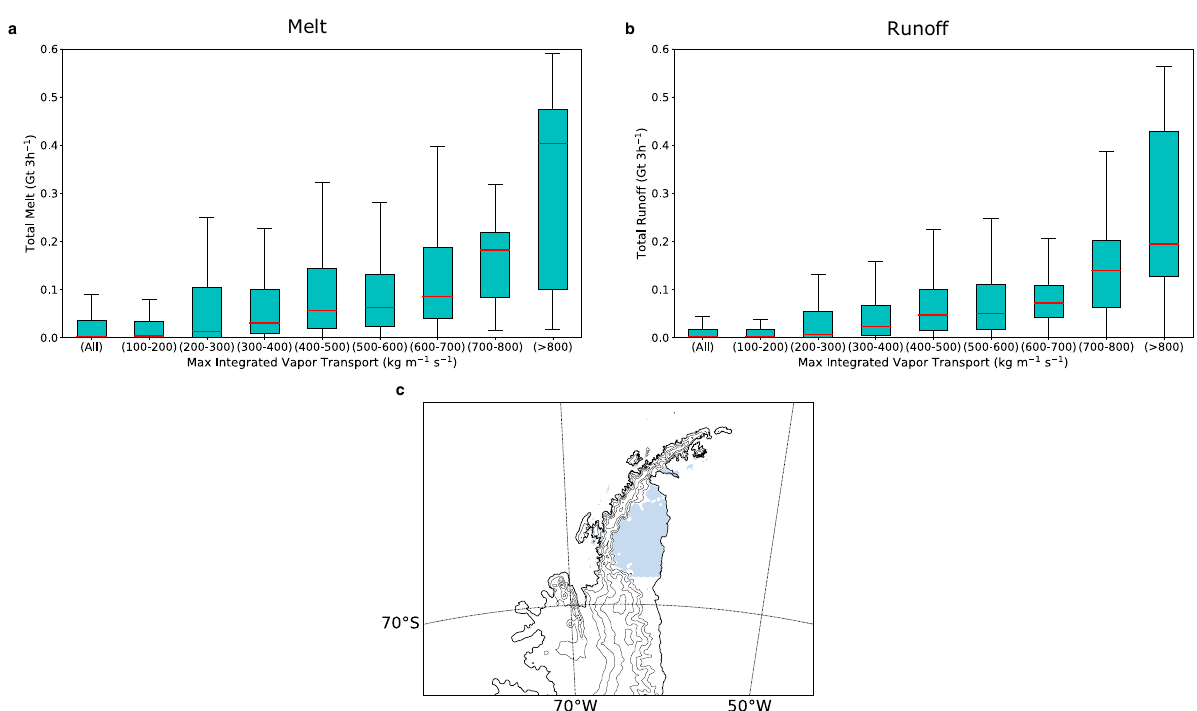
Fig. 5 The relationship between AR intensity and melt/runoff intensity. The maximum integrated vapor transport (IVT) upon landfall for each detected AR timestep and the corresponding 3-hourly cumulative a surface melt and b runoff over c the area shaded in blue using MERRA-2 for IVT and MAR for surface melt and runoff. The most common IVT intensity was 300-400 kg m − 1 s − 1 (n = 273), while the least common IVT intensity was >800 kg m − 1 s − 1 ( n = 14) over the December – March period. The boxes represent values from the fi rst to the third quartile, the red line is the median, and the whiskers extend to the data maximum and minimum. The area of the blue shaded region is ~91,400km 2